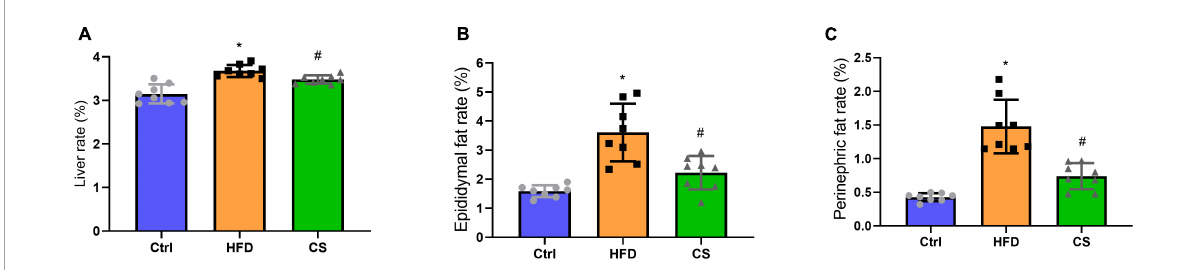
FIGURE2 Effect of corn silk extract on liver, epididymal fat and perinephric fat rate (%). (A) liver rate; (B) epididymal fat rate; (C) perinephric fat rate. Control diet (Ctrl) group, high- fat diet (HFD) group, corn silk (CS) group. The results are means ± SD ( n = 8). * p < 0.05 vs. Ctrl, # p < 0.05 vs. HFD.